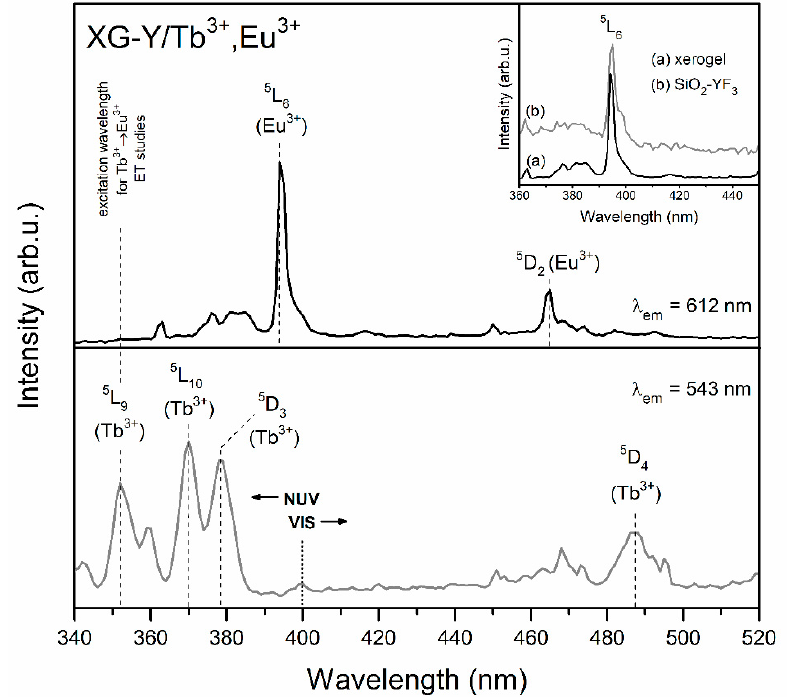
at λ em = 543 nm and λ em = 612 nm. Figure 2. Photoluminescence excitation (PLE) spectra of XG-Y / Tb 3 + ,Eu 3 + co-doped sample, monitored